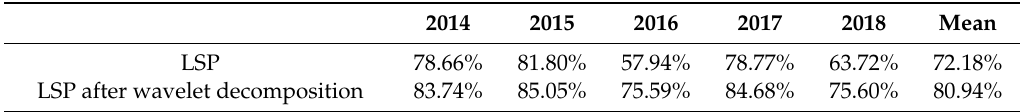
Figure 9. Daily data utilization rates of the two methods in 2014 ( a ), 2015 ( b ), 2016 ( c ), 2017 ( d ) and 2018 ( e ). Blue and red lines denote the data utilization rates for snow depth estimation with LSP and LSP after wavelet decomposition, respectively. The data utilization rate refers to the ratio of individual-satellite-derived snow depths actually used to calculate the daily averaged snow depth. Table 2. Annual data utilization rate of the two methods over five years. The data utilization rate denotes the annual mean of daily data utilization rates.